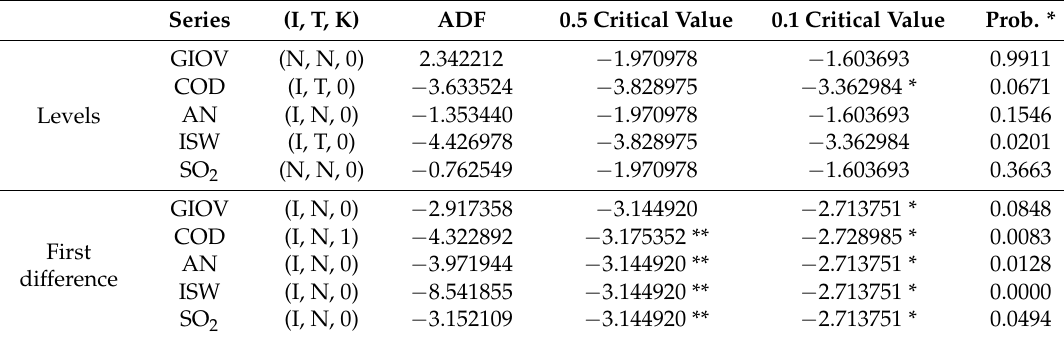
Table 3. Unit root test results for petroleum and natural gas